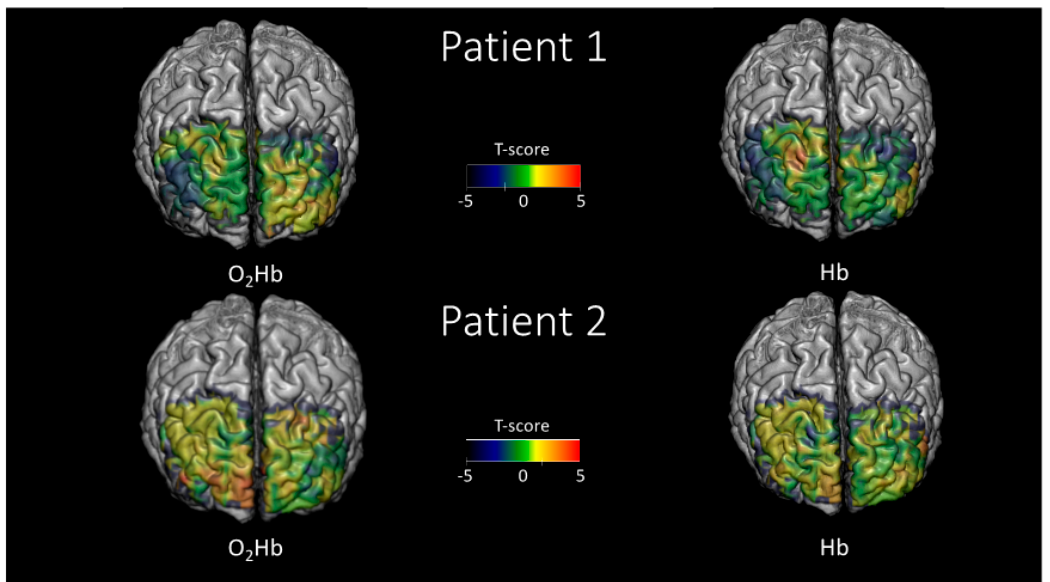
Figure 6. Statistical parametric maps (t-scores) evaluated employing the functional near-infrared spectroscopy-diffuse optical tomography (fNIRS-DOT) analysis and comparing the variability of the signal between task and rest for the Digit Span (DS) backward test. The maps are reported in regions where the spatial sensitivity of the optical array was sufficient (up to an attenuation of the average optical sensitivity of 1000 times).